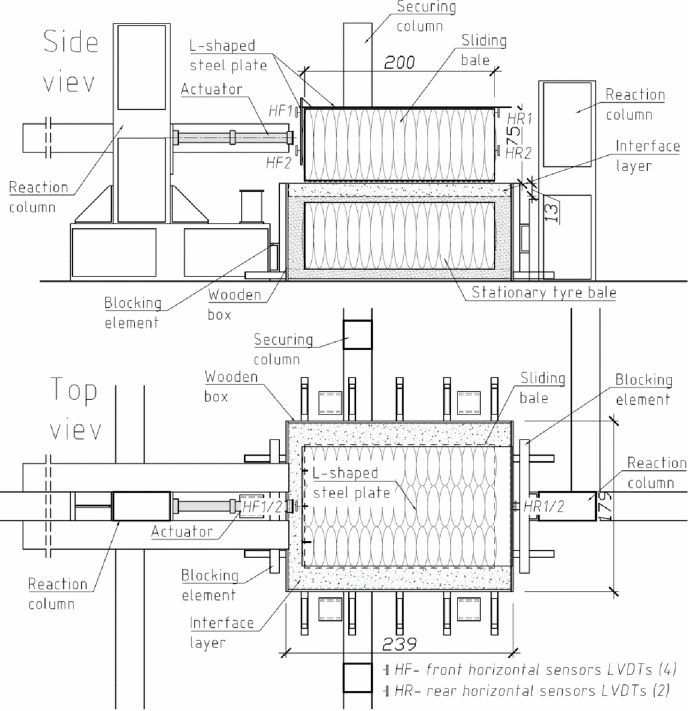
Figure 8. Tyre bale–soil interface test stet-up (without additional normal loading). The sliding bale was placed on the soil layer and shifted horizontally with a hydraulic actuator. In this case, the horizontal shear load was applied at a distance of about 0.38 m (1/2 the height of the bale) from the bottom of the sliding bale. An L-shaped 20-mm thick steel plate was placed on the sliding bale; the vertical part of the plate distributed the load applied by the actuator on the loaded face of the sliding